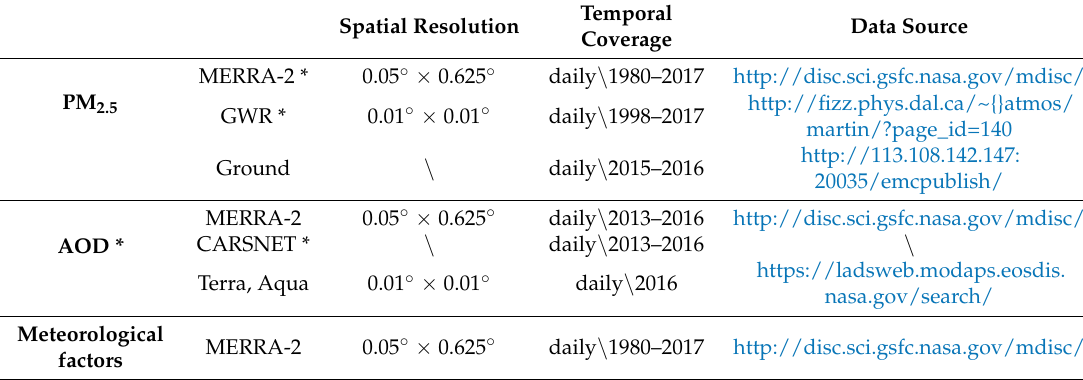
Table 2. Summary of data used in this